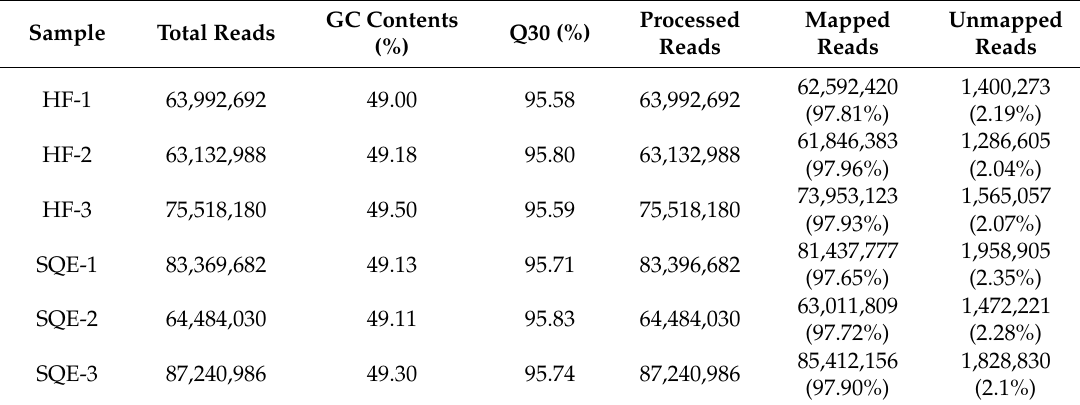
Table 2. Summary of sequencing read alignment to the reference genome.